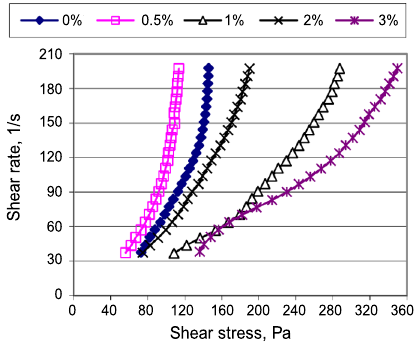
Fig. 9. Cement paste with CEM II N cement shear stress vs shear rate after 150